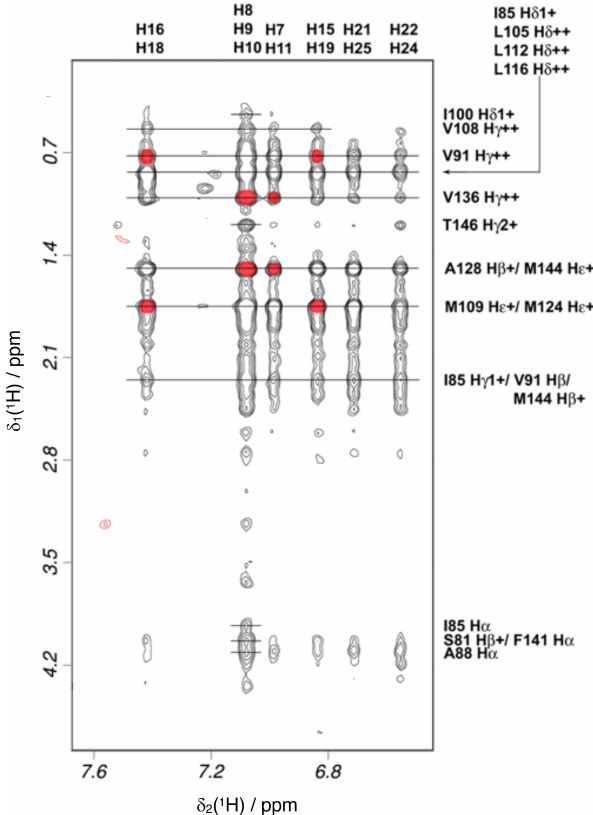
Figure 5. Intermolecular NOEs between idoxifene and CaM. A region of the 2D 13 C- 15 N-double-half-filtered NOESY spec- trum of the 2 : 1 idoxifene : CaM complex, processed to exclude the 13 C / 15 N bound resonances in the ω 2 dimension and to in- clude only the 13 C bound resonances in the ω 1 dimension. The ligand resonances corresponding to each strip are marked on the top edge as follows: p -iodo-phenyl ring (H16 / H18), phenyl ring (H8 / H9 / H10), phenyl ring (H7 / H11), p -iodo-phenyl ring (H15 / 19), and p -phenoxy ring (H21 / 25 and H22 / 24). Assignments of the resonances from tr2c are shown on the right. A red circle over the cross peak indicates examples of NOEs that are violated in the structure calculation corresponding to the data in Fig.